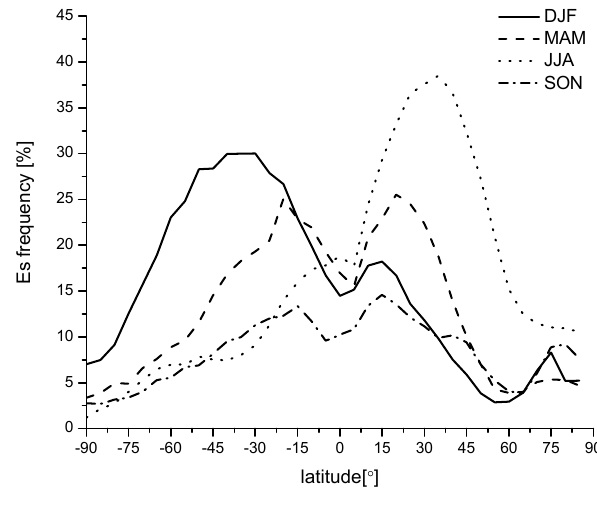
Fig. 2. Total E s occurrence frequency in a given latitude interval, for 4 different